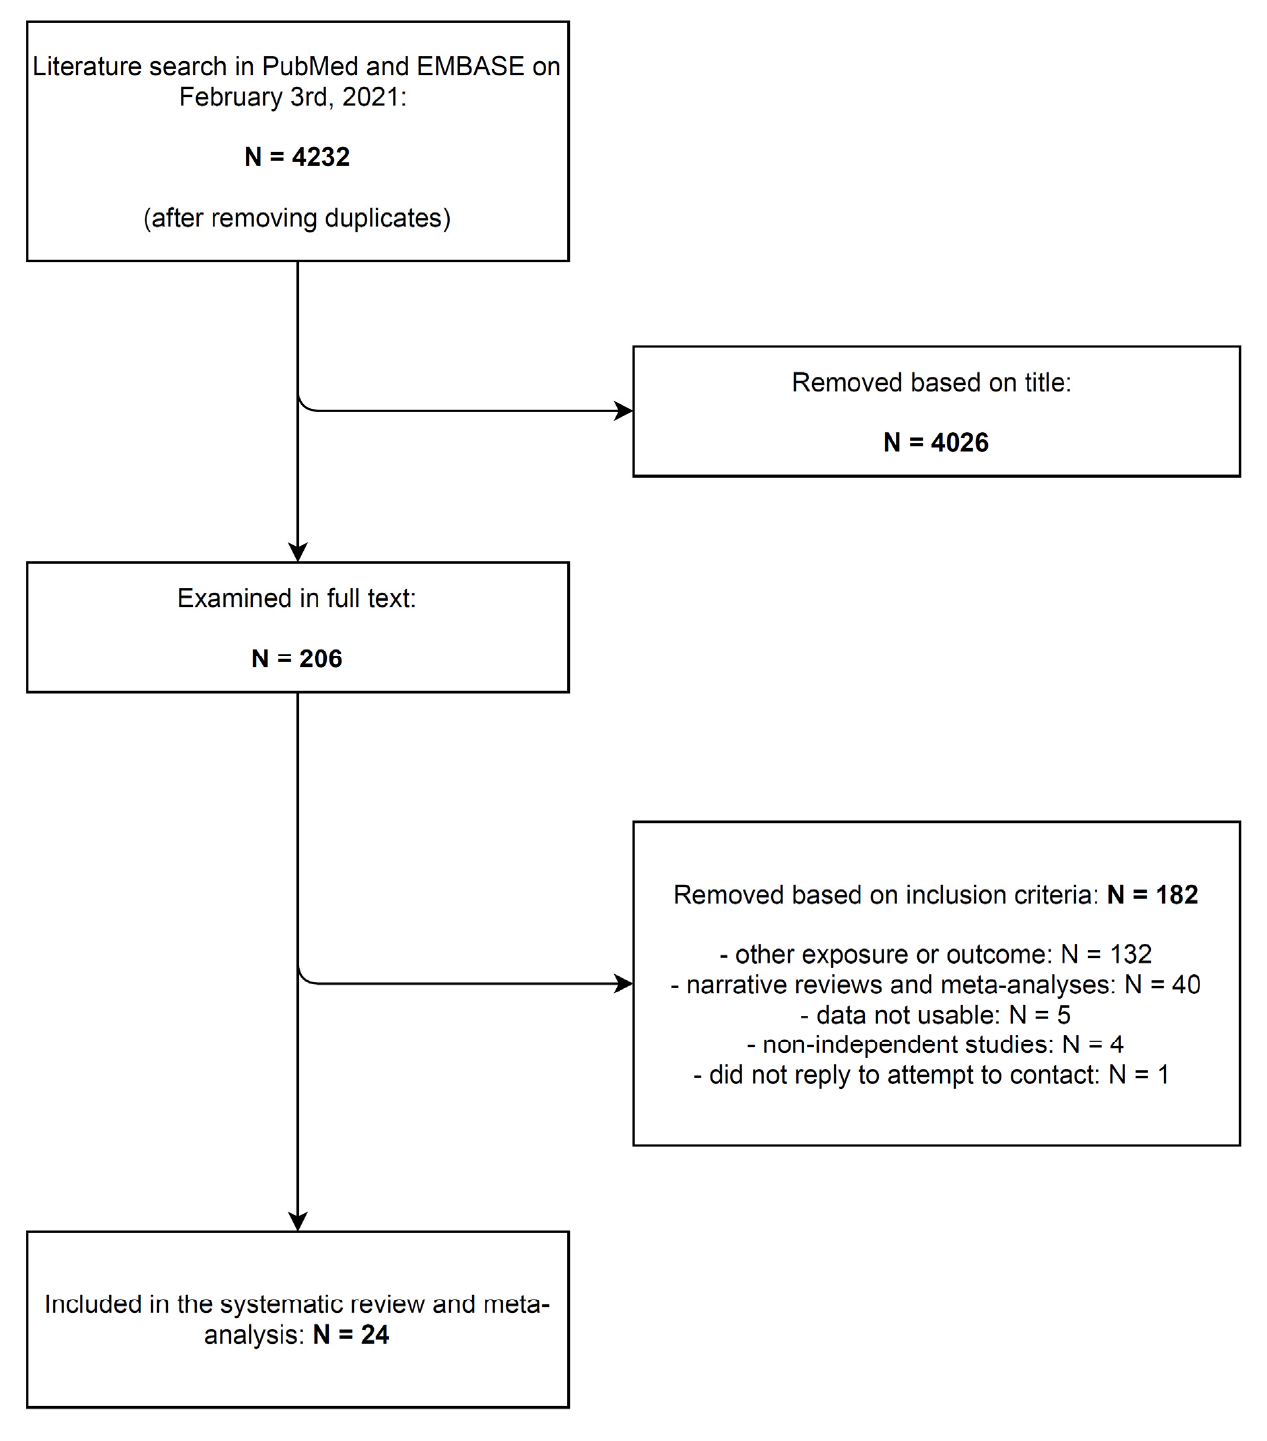
Figure 1. Article selection for the systematic review and meta-analysis on the association between vitamin D receptor ( VDR ) and vitamin D binding protein ( VDBP ) genes polymorphisms, vitamin D blood concentration, and vitamin D dietary intake and supplements use, and non-melanoma skin cancer risk.